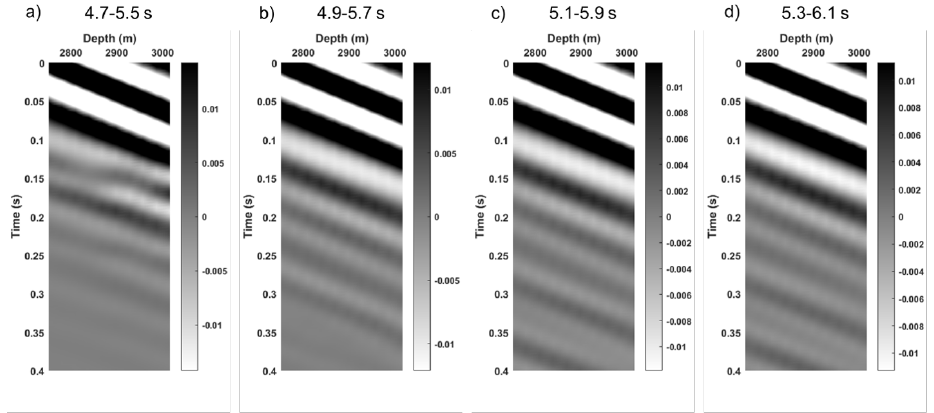
Figure 19. Transmission response from time-varying interferometry of check shot SP2. Times above each panel indicate the time window of the check shot record used as an input for interferometry.